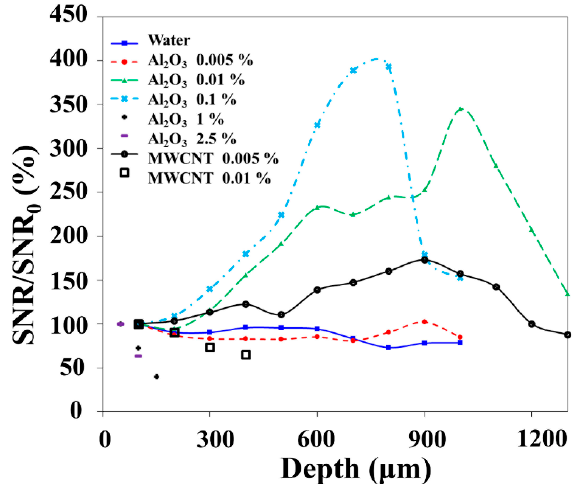
Figure 3. Variation of correlation signal-to-noise ratio (SNR) with changes in the focal plane depth. SNR is normalized with SNR 0 (peak to correlation energy at the smallest z for each case).